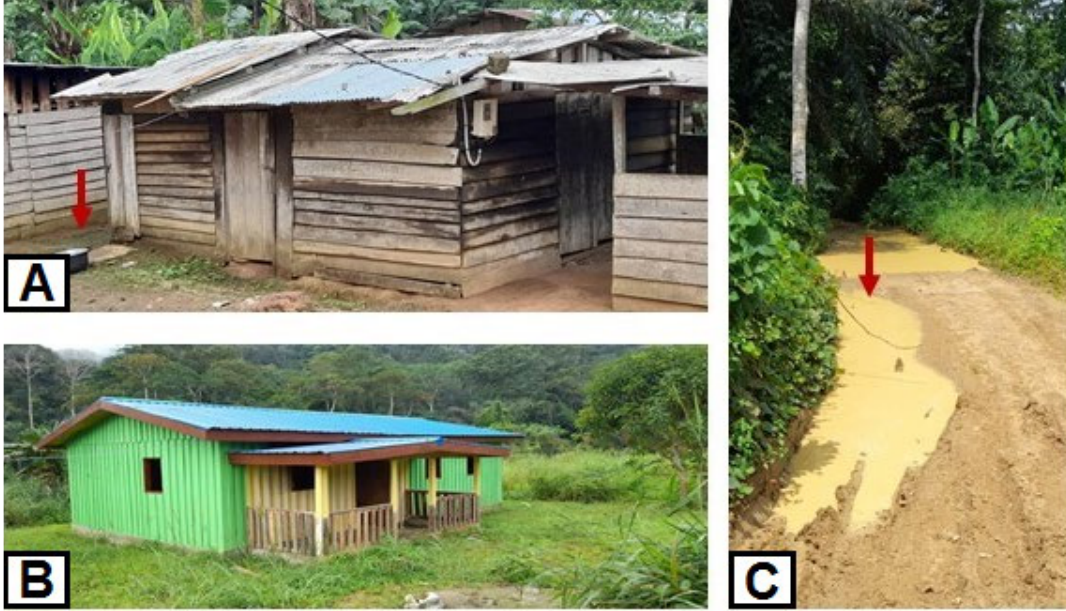
Figure 6. The environment of the village. (A) represents the traditional wooden house that is owned by 95% of villagers. (B) represents the modern wood house. (C) represents the tracks of wood transporting trucks creating pools of water where >1000 anophelinae were found. The water pool is <5m from the closest